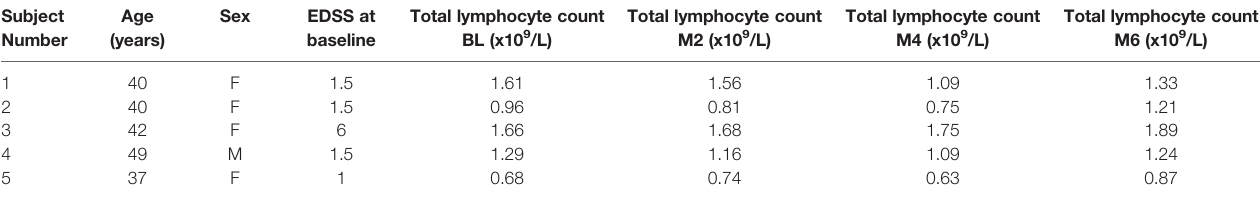
TABLE 1 | CCMR-One patient demographic